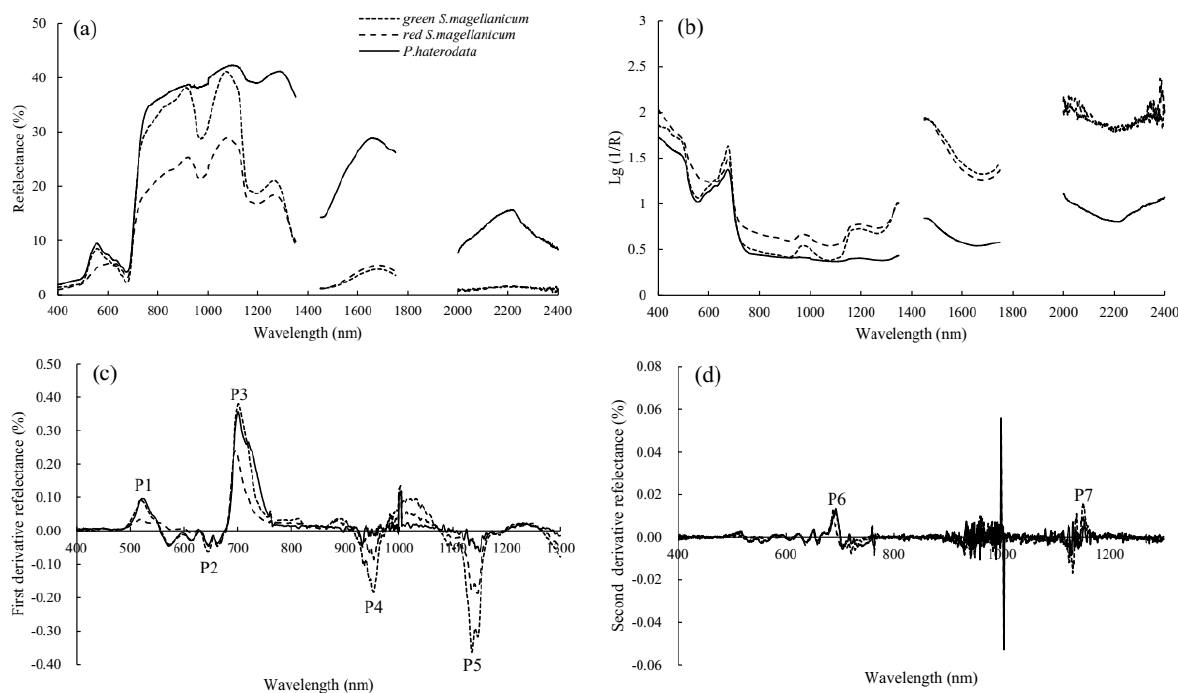
Figure 8. Spectral analysis of P. heteroclada Oliver and S. magellanicum including: (a) original spectra, (b) lg(1/R) spectra, (c) FDR spectra, and (d) SDR spectra (Pang et al. 2019). The labels P1–P7 indicate notable reflectance peaks among